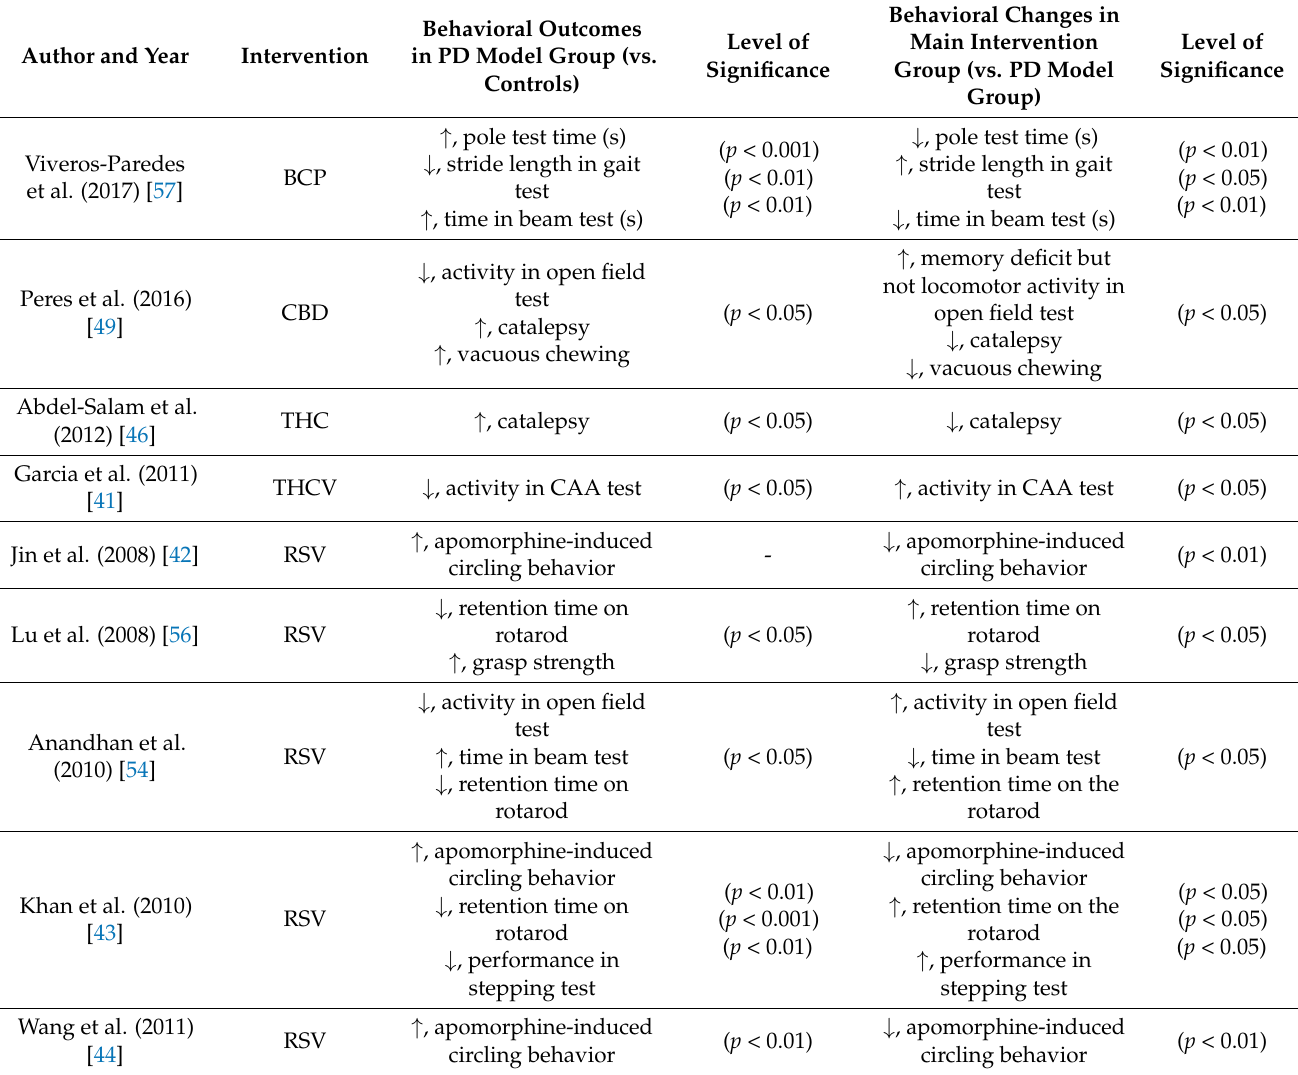
Table 3. Summary of behavioral outcomes in PD model groups and